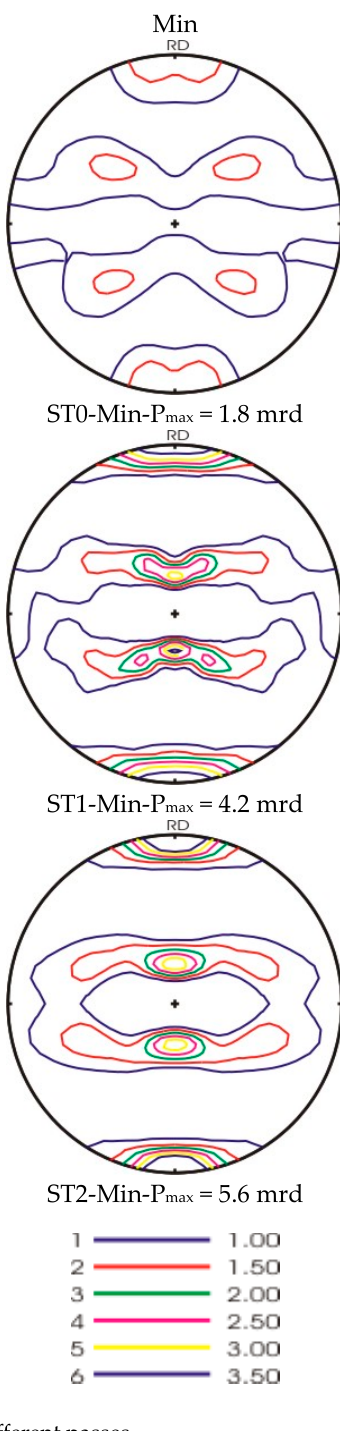
Figure 9. The (111) pole figures of tube 4ST after different